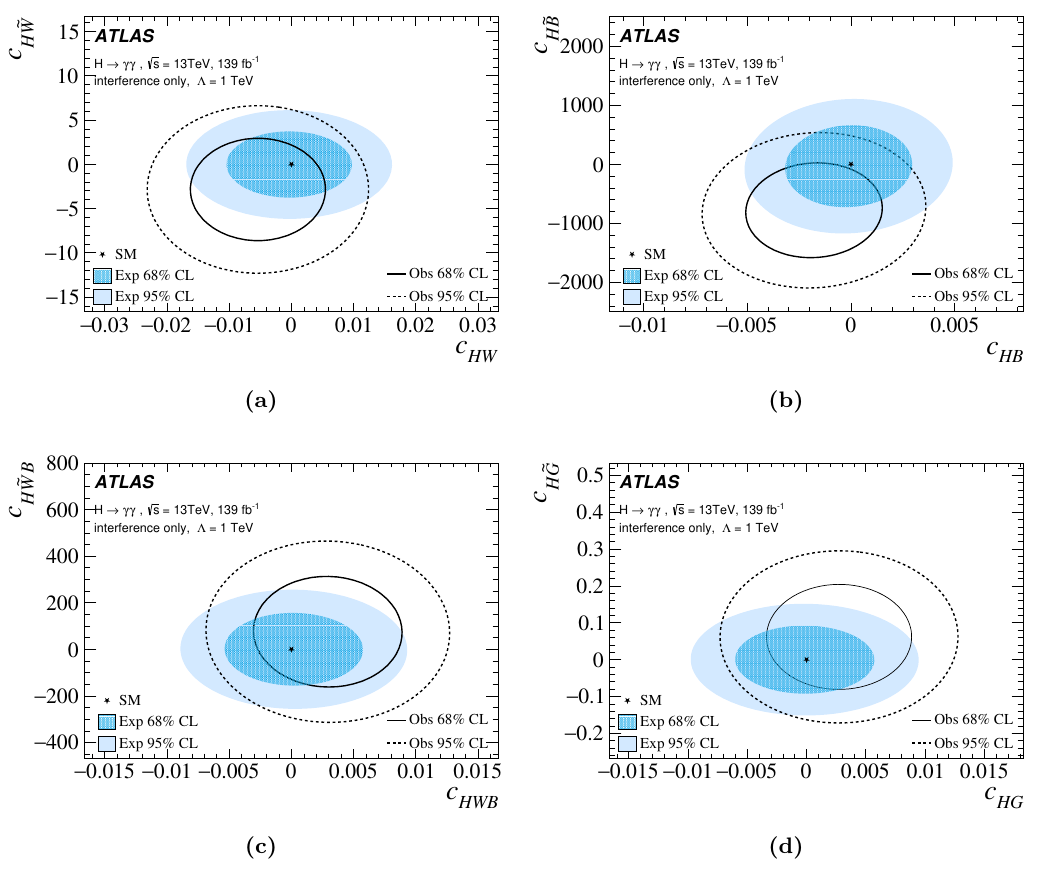
Figure 37. Plots showing the 2D 68% and 95% observed and expected limits obtained from various combinations of two Wilson coefficients using only the SM-dimension-6 interference in the SMEFT basis: (a) c vs c , (b) c vs c , (c) c vs c , (d) c vs c . The limits are HW HB HWB HG H e W H e B H e WB H e G computed at a new-physics scale Λ = 1 TeV